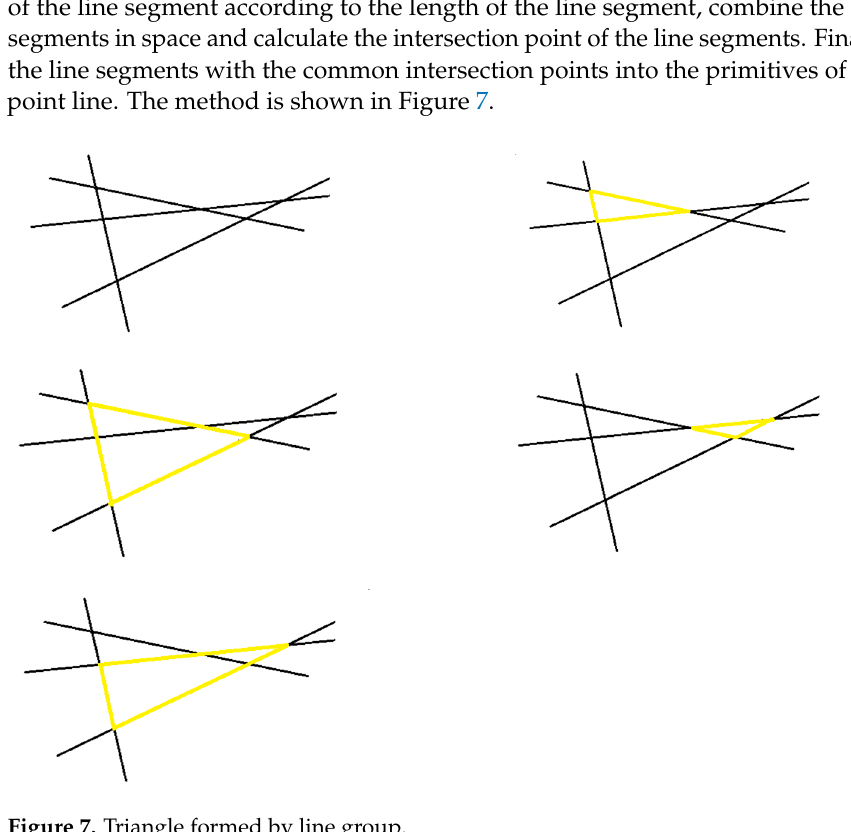
Figure 7. Triangle formed by line